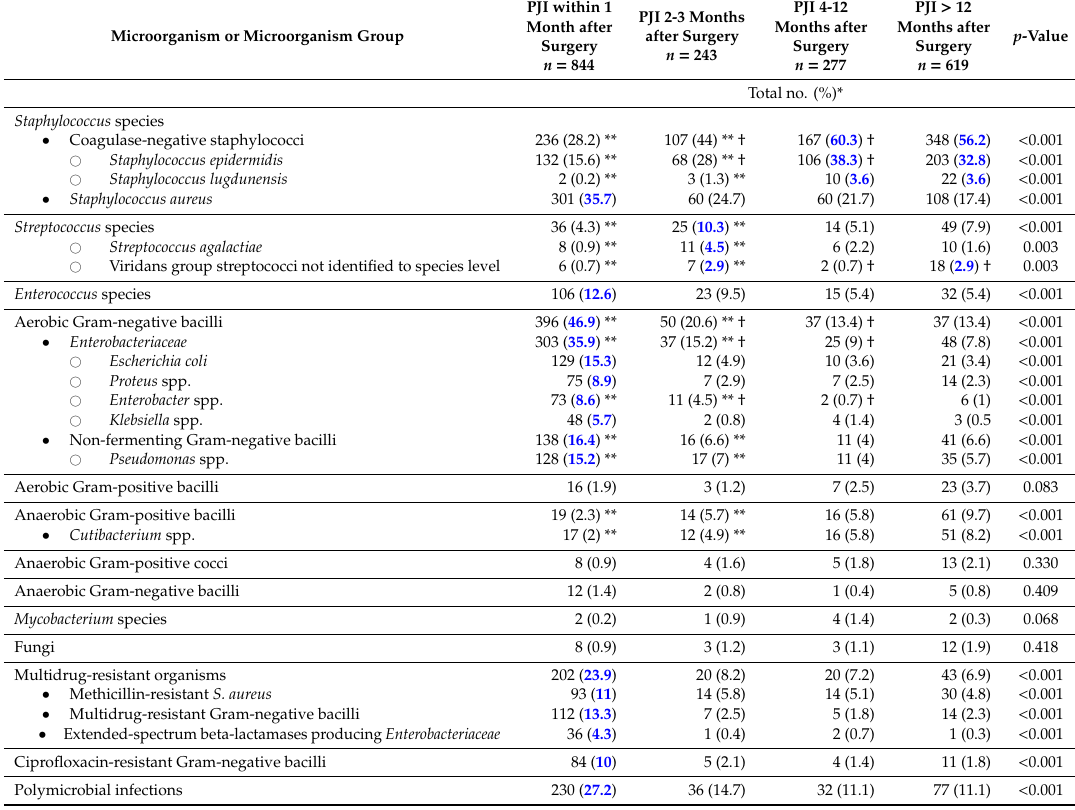
Table 4. Microorganisms and groups of organisms involved in non-hematogenous prosthetic joint infections according to time of infection after surgery ( ≤ 1 month, 2–3 months, 4–12 months, > 12 months). Microorganism or Microorganism Group